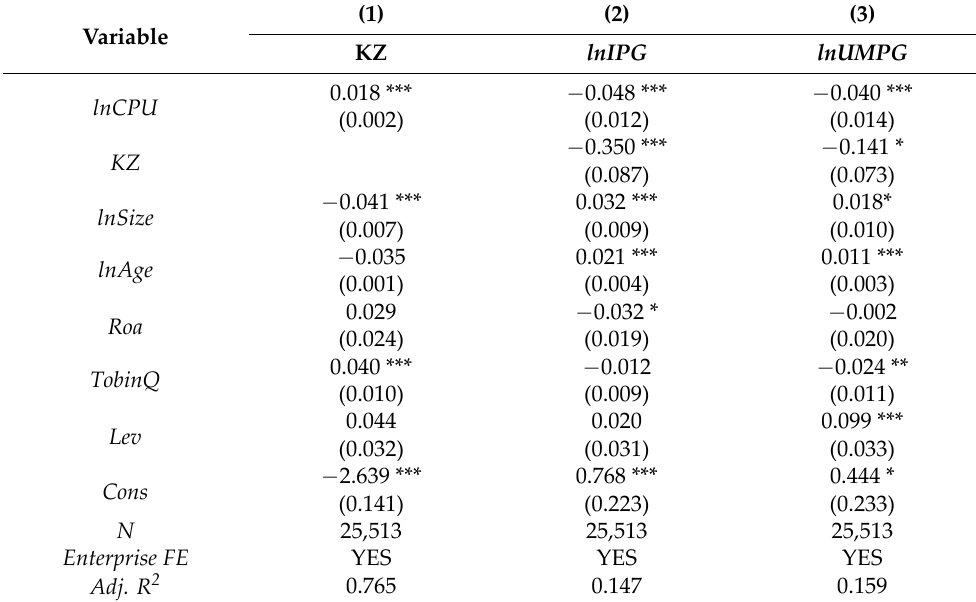
Table 5. Mediating effects